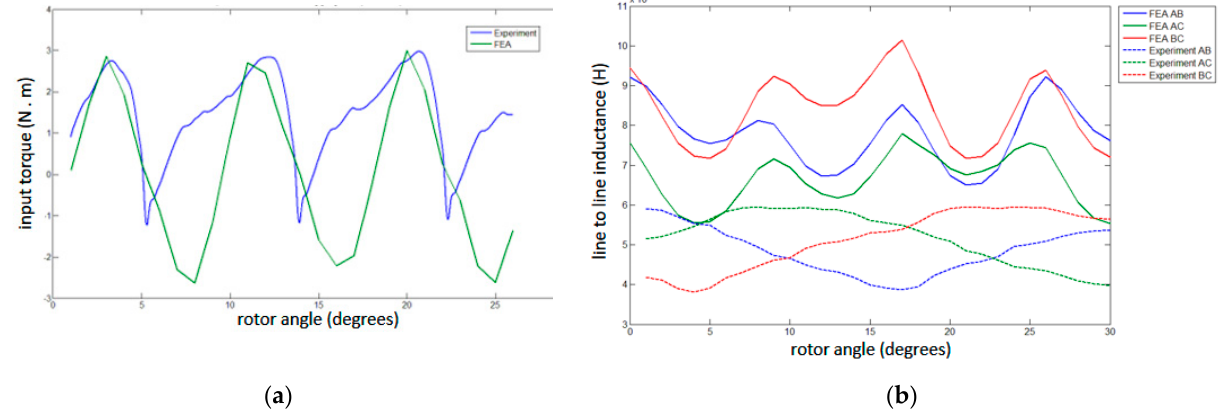
Figure 13. Comparison of angular dependent parameters for experimental measurements vs. FEA predictions. ( a ) Cogging torque. ( b ) Line to line inductances.